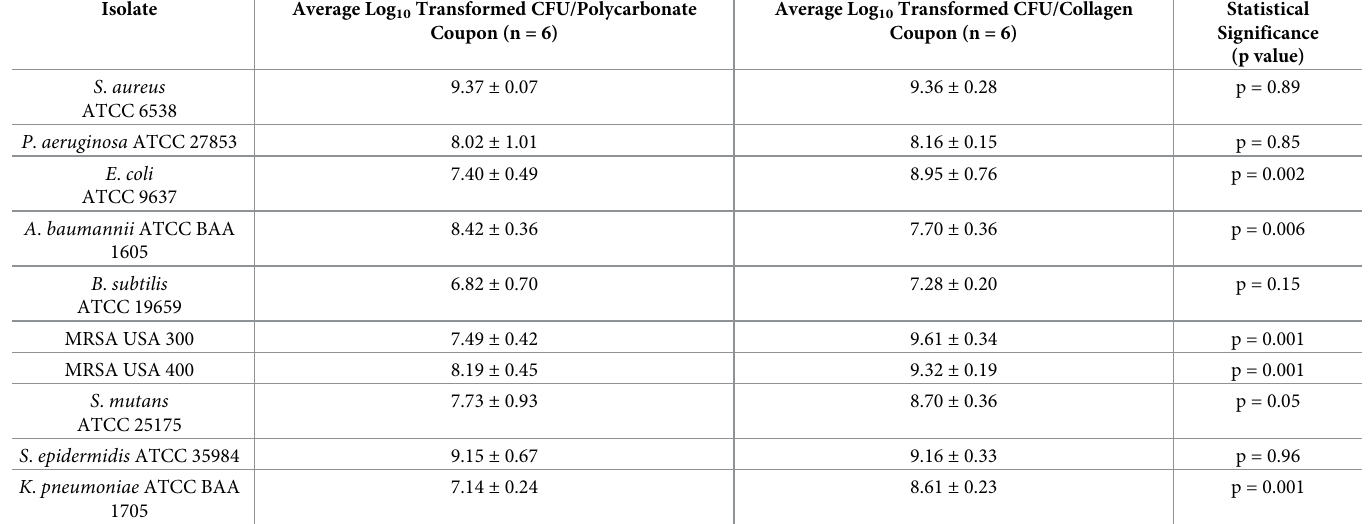
Table 1. Baseline (control) quantifications of coupons.